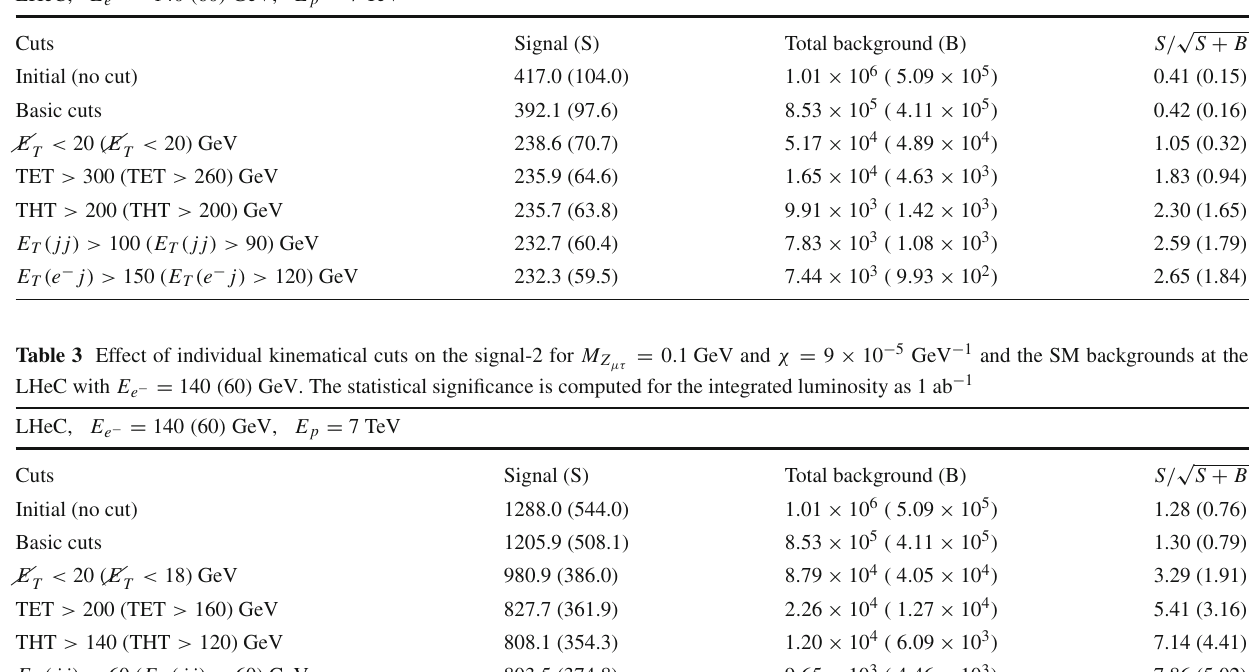
Table 2 Effect of individual kinematical cuts on the signal-1 for M h backgrounds at the LHeC with E e − = 140 ( 60 ) GeV. The statistical significance is computed for the integrated luminosity as 1 ab − 1 LHeC, E e − = 140 ( 60 ) GeV, E p = 7 TeV